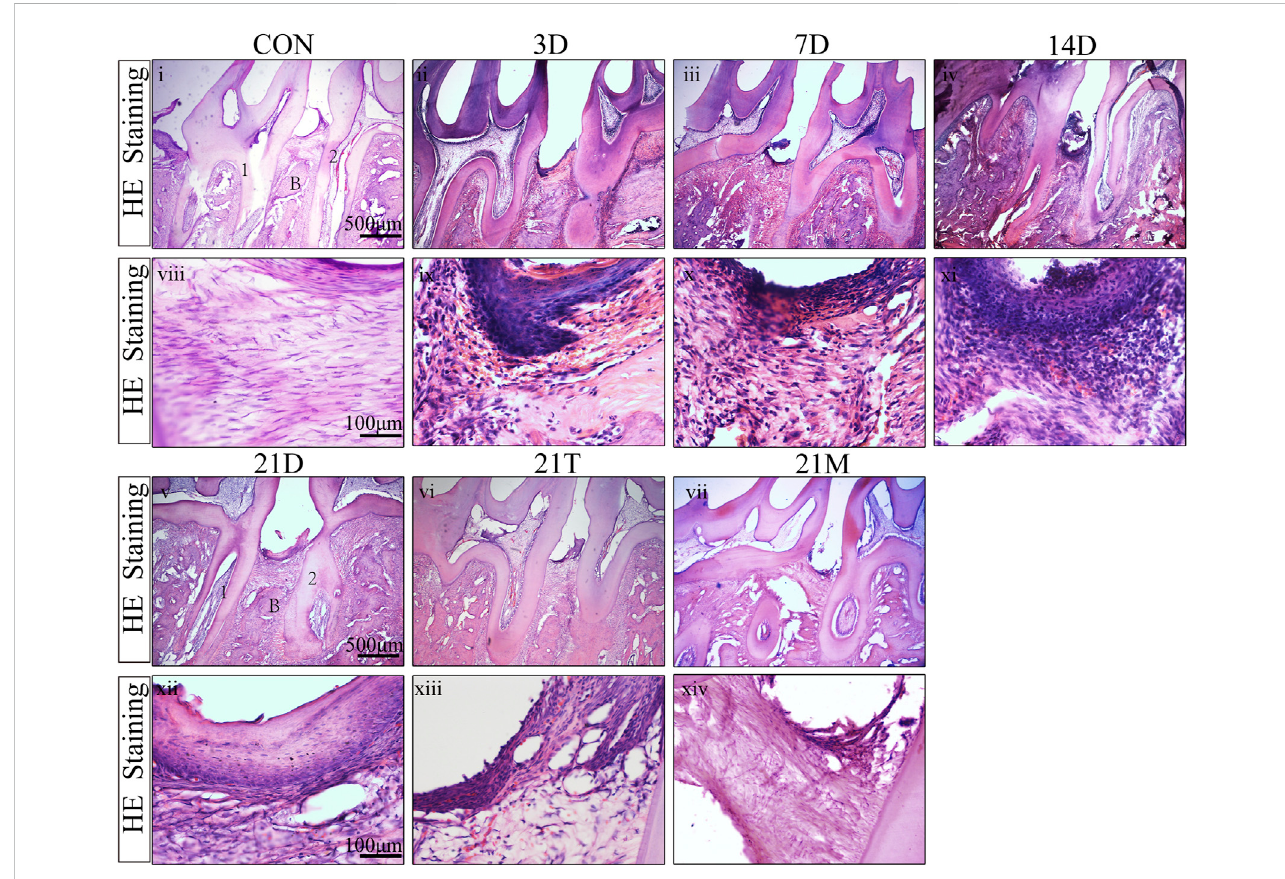
FIGURE 4 H&E staining result Representative H&E stained sections of periodontal tissues harvested from each group at low (i-vii) and high (viii-xiv) magni fi cations. 1, the root of the fi rst molar; 2, the root of the second molar; B, alveolar bone.